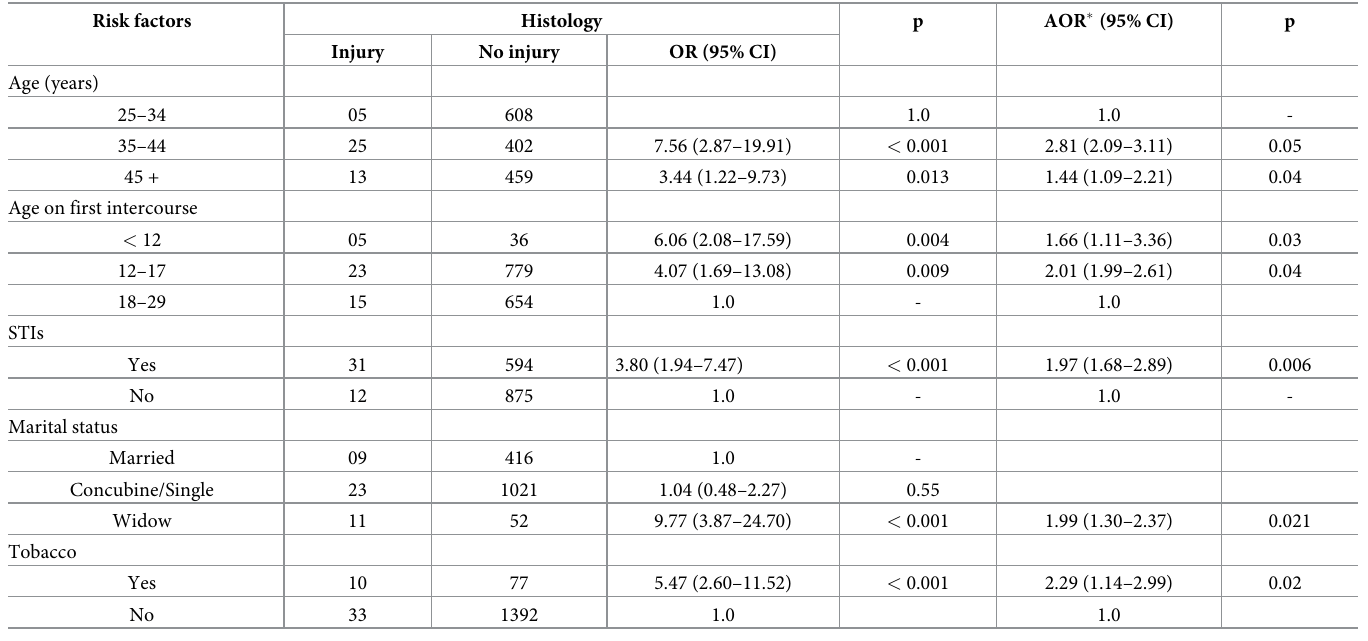
Table 4. Risk factors of precancerous lesions.